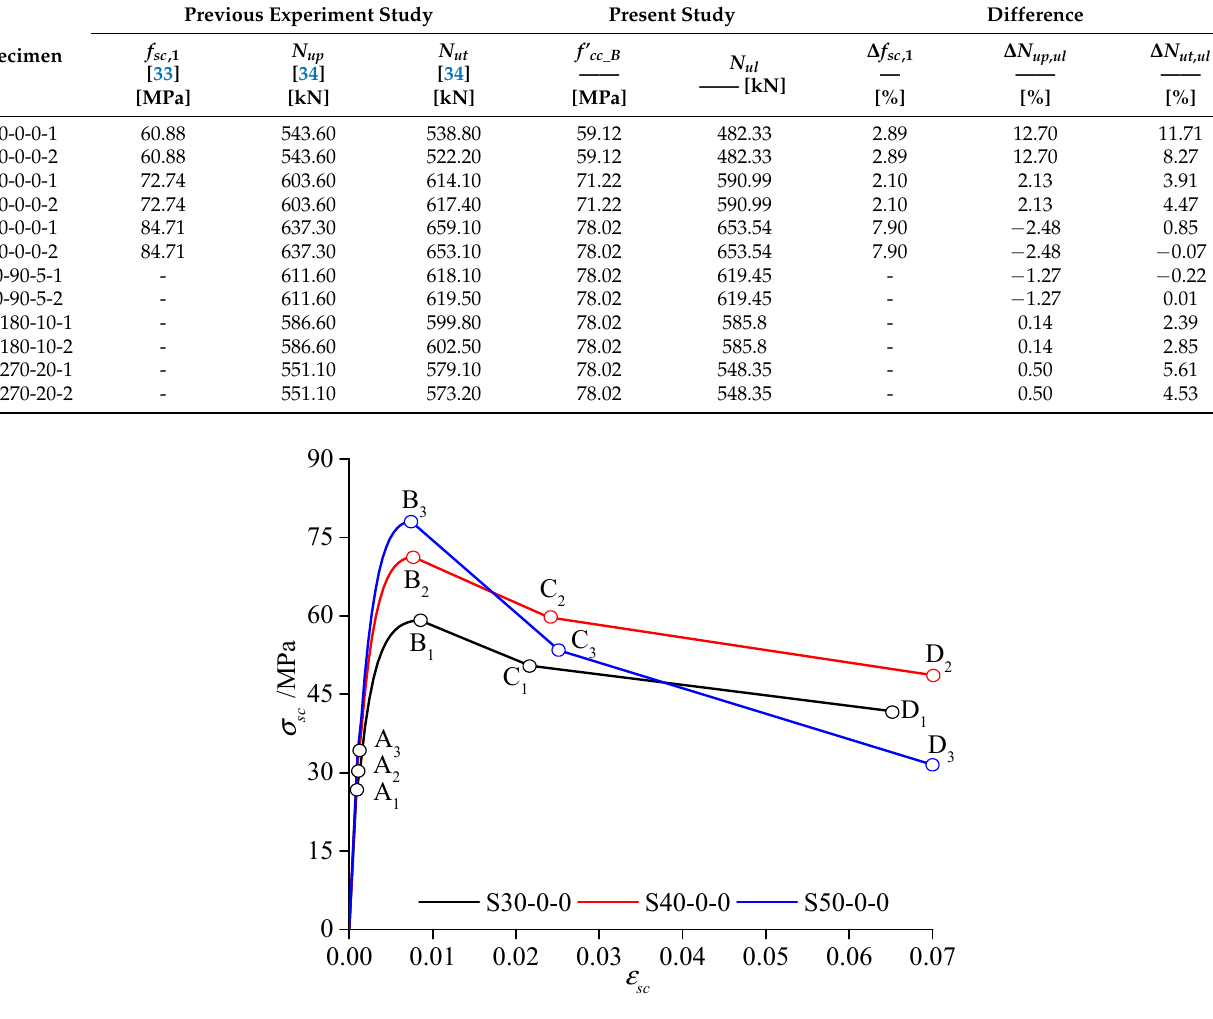
Figure 4. Stress–strain model for confined CFST.